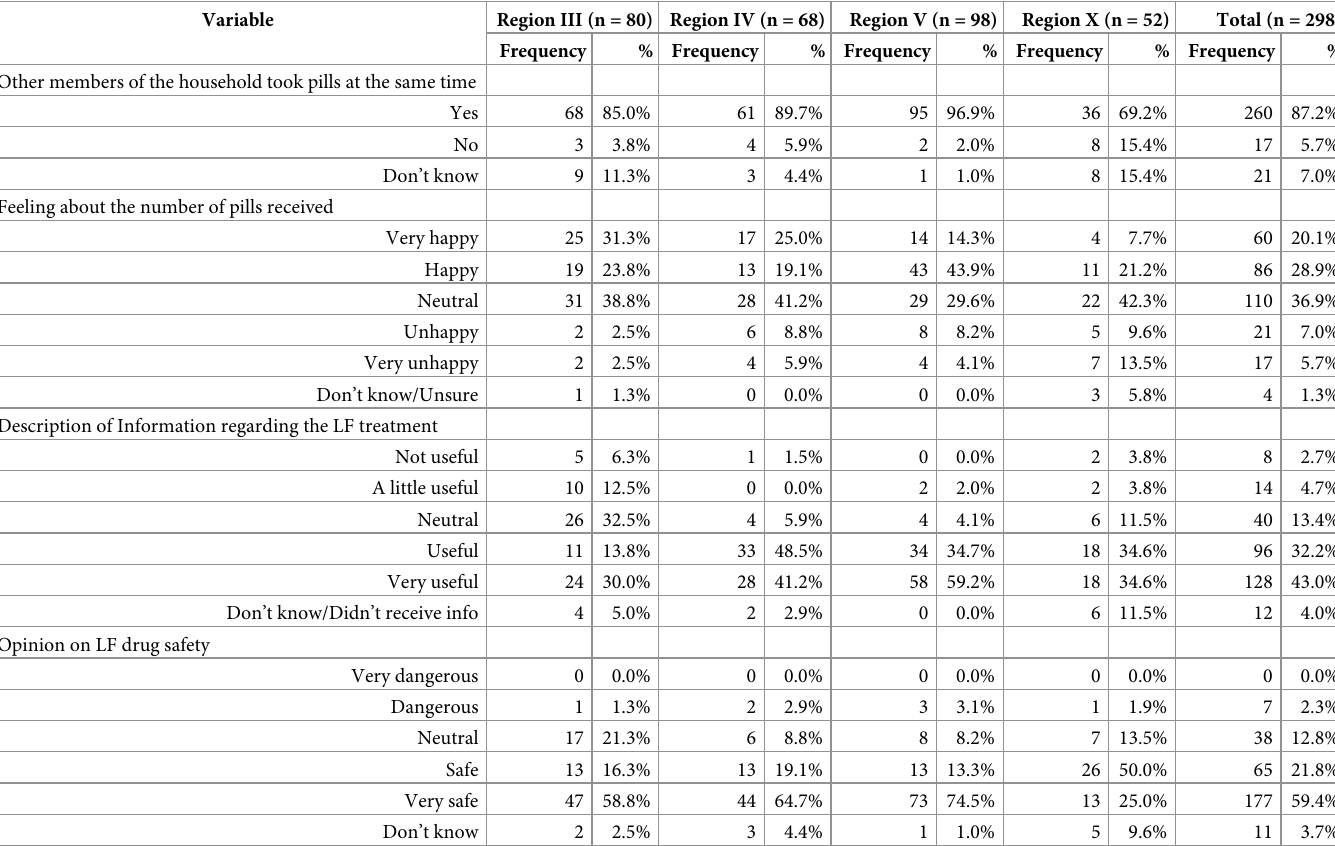
Table 7. Descriptive analysis of key variables in a subset of the primary study population who have previously participated in an MDA.